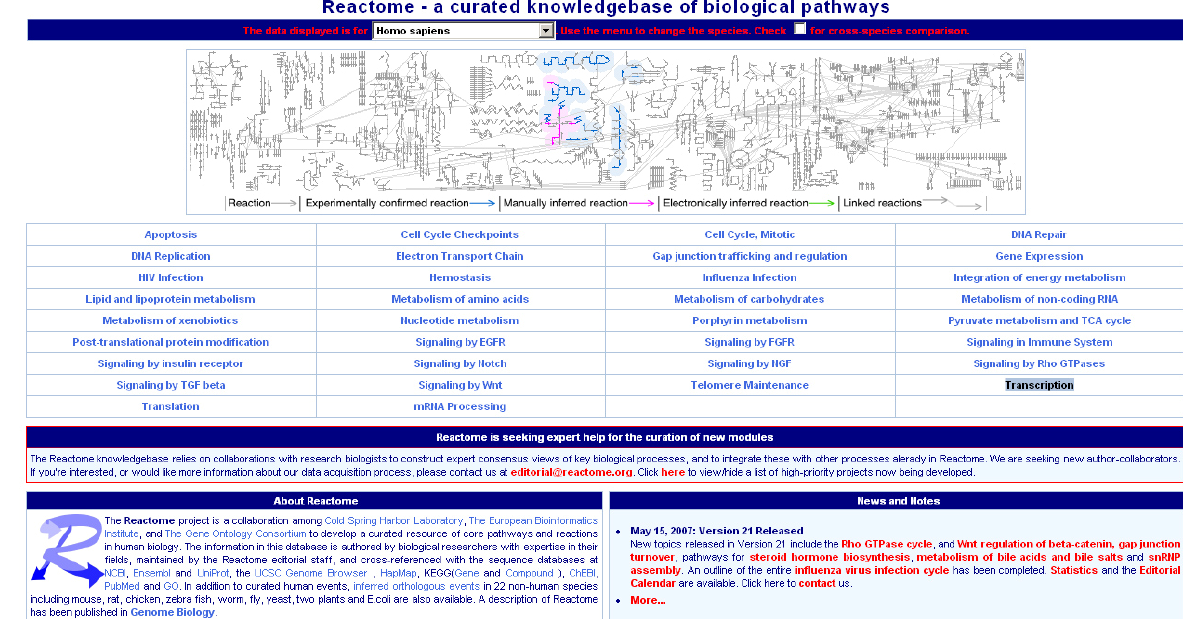
Figure 3: The Reactome home page. This view highlights the Transcription Pathway on the ‘Sky’ panel and in the pathway table beneath